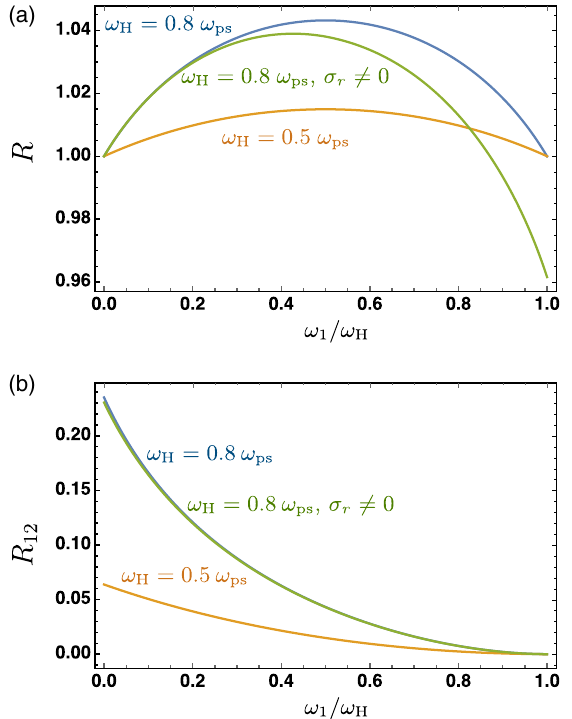
FIG. 2. (a) Reflection coefficient R and (b) downconversion intensity R 12 as a function of the signal frequency ω 1 . We assume ϵ 5 , ϵ 5 . 62 (corresponding to diamond), and Λ 0 . 4 Λ . s ¼ out ¼ m ¼ s Two different values of the Higgs frequency were taken, ω ffiffiffiffiffiffiffiffiffiffiffiffiffiffiffiffiffiffiffi p H ¼ 0 . 5 ω 0 . 8 ω Λ = ð ε ϵ and ω , where ω is the super- 0 ps H ¼ ps ps ¼ s s Þ conducting plasma frequency. The green curves, corresponding 0 . 8 ω to ω , illustrate the effects of dissipation, taken into H ¼ ps − σ ð ω Þ = ð i ε ω Þ with σ ð ω Þ ¼ account by assuming ϵ ð ω Þ ¼ ϵ 0 s i Λ = ð ω þ i 0 þ Þ , where σ σ is a real constant; the blue and r þ s r 0 . Results are for the orange curves include no dissipation, σ r ¼ model in which Λ m is uniform in